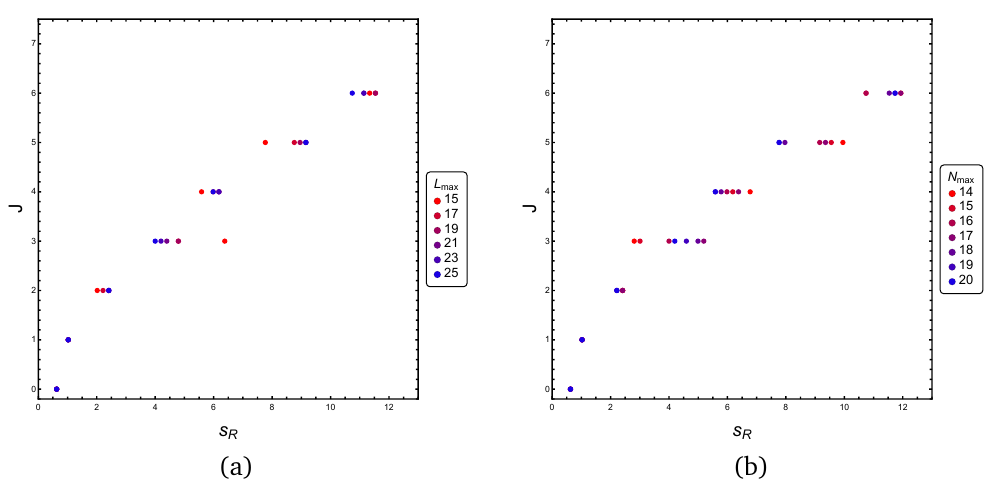
Figure 12: (a) This shows convergence of peaks for L max ∈ [ 15, 25 ] at N max = 16 and fixed ( s 0 , s 2 ) = ( 0.35, 2.89 ) (b) This shows convergence of peaks for N max ∈ [ 14, 20 ] at L max = 25 and fixed ( s 0 , s 2 ) = ( 0.35, 2.89 )